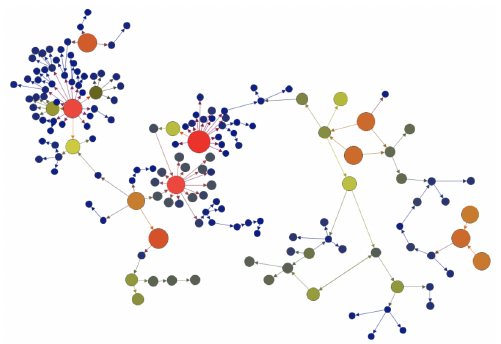
Figure 2. A sample of infection